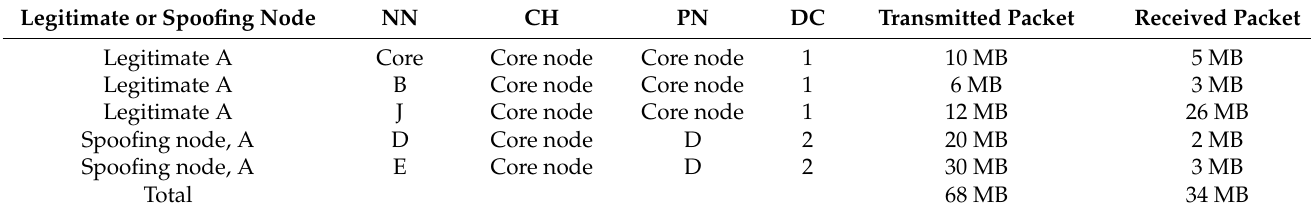
Table 3. Connectivity list for spoofing